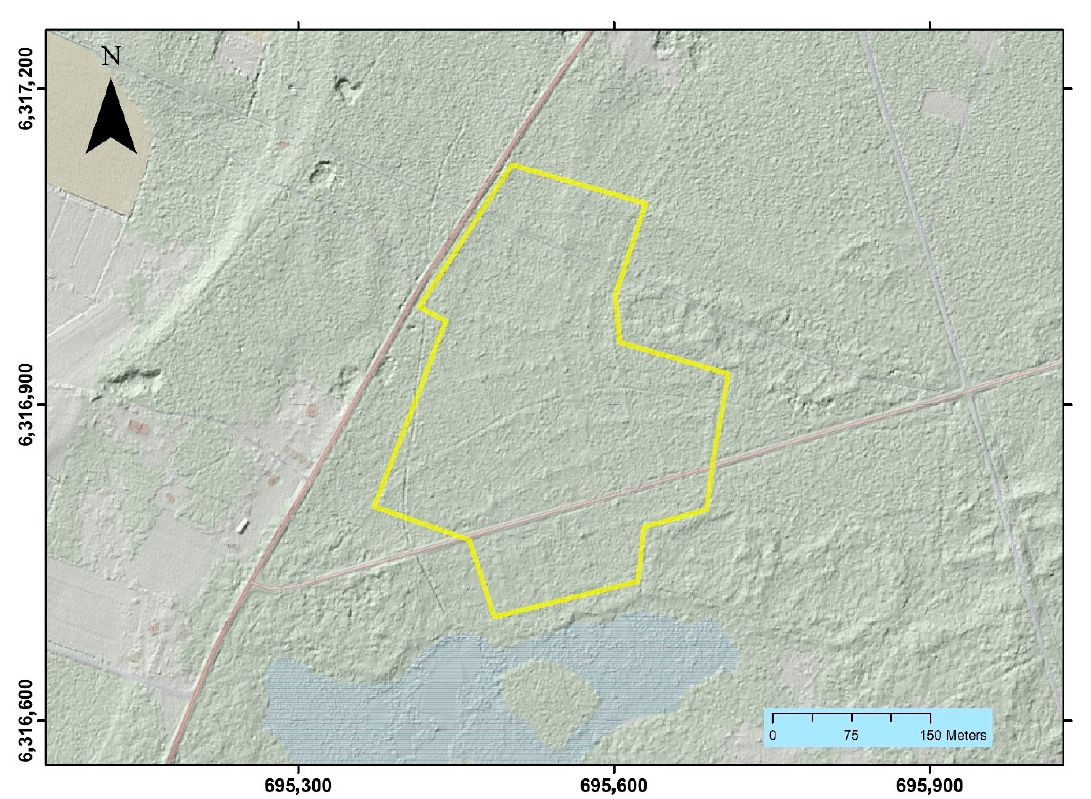
Figure 8. Sundre parish, Gotland. The yellow polygon encircles unrecorded Celtic fields. The eastern part of the encircled area has recently been subjected to tree felling (after the ALS survey). The earthworks in this part were hard to detect at field inspection due to the work done in the area. The western part was also subjected to forestry and reforestation a few decades ago. In this part the earthworks were well preserved. In this case, ALS is an important indicator to the state of preservation before felling. Coordinates: SWEREF99 TM. © Lantmäteriet Geodatasamverkan.